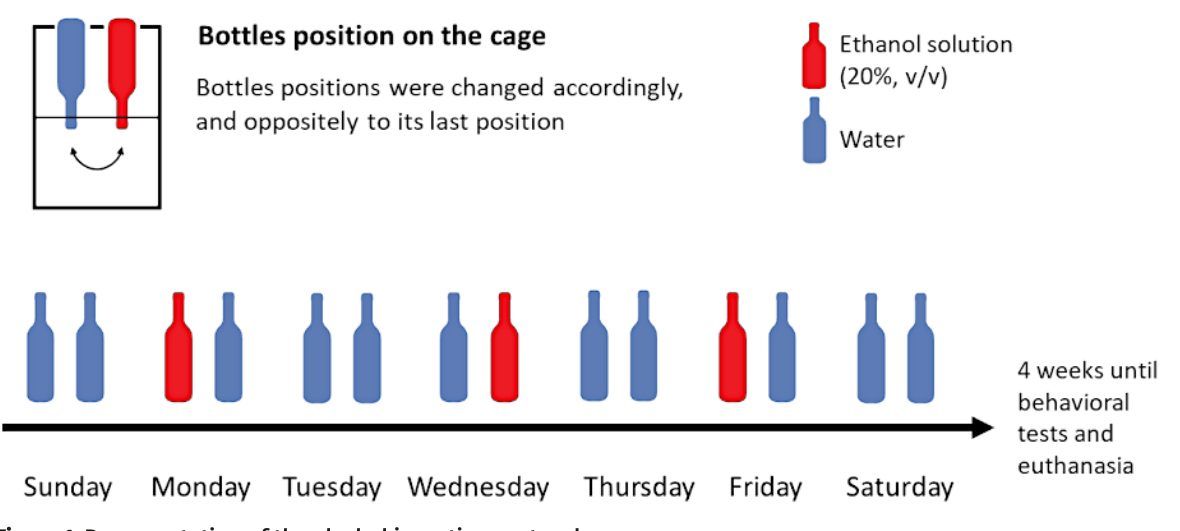
Figure 1. Representation of the alcohol ingestion